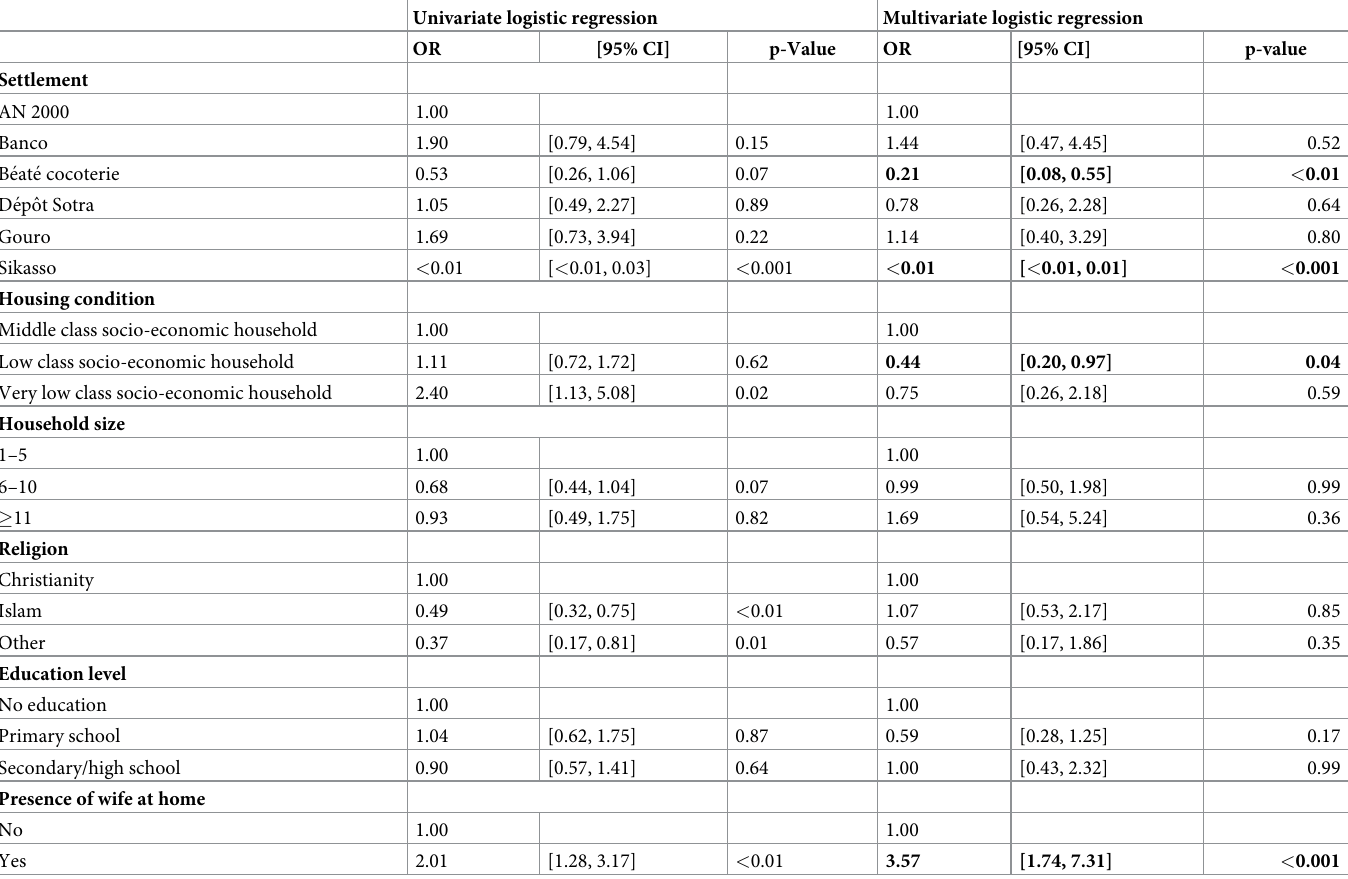
Table 3. Univariate and multivariate logistic regression for associations between identified factors and access to clean water in settlements investigated in Yopougon. Univariate logistic